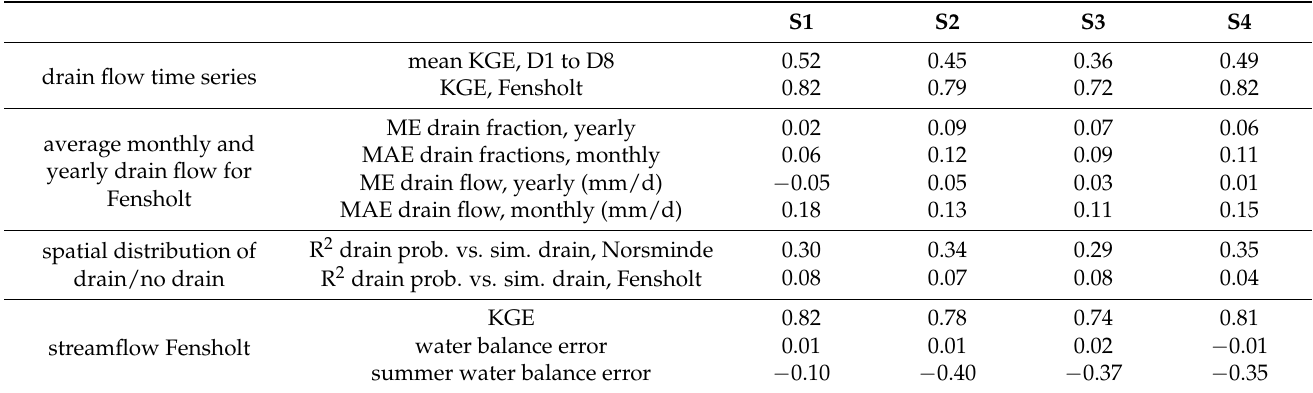
Table 5. Overview over validation metrics of drain flow and spatial distribution of drain across the four calibration scenarios. The last three rows present results for streamflow at the outlet of the Fensholt sub-catchment; these data were not used in the calibration. S1 S2